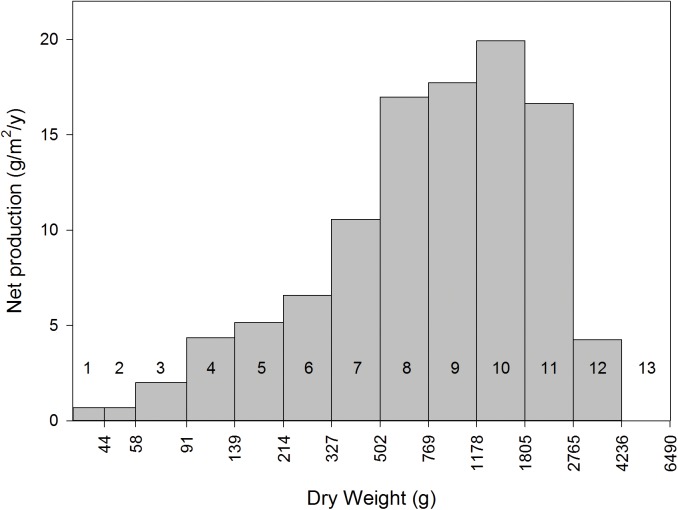
Net annual dry-weight production, by weight class, of corymbose Acropora on reef flats and crests at KWMA.Assuming weight and age are positively related, each bar represents a year-class. Putative age is indicated by the number above or in a given bar. Excluded from the plot is the influence of two colonies estimated to be 8059 and 18,877 g. Note that dry weight is plotted on a logarithmic scale.